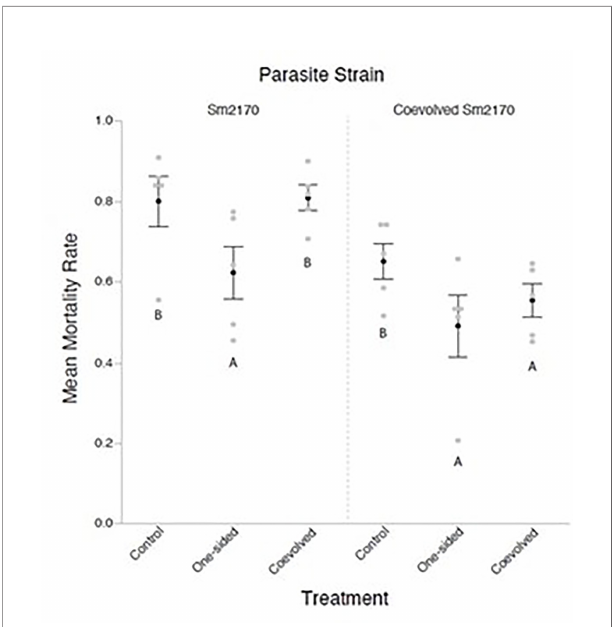
FIGURE 2 | Host Mortality across related parasites. For each mortality assay 200 Worms were exposed to S. marcescens for a period of 48 hours using Serratia Selection Plates. Surviving worms were counted and the mortality is expressed as (worms plated – worms counted)/worms plated). Black circles represent the average mortality rate across all host populations for each bacterial treatment group. White circles represent the average mortality rate across all replicates for one host population. Points which share letters are statistically indistinguishable from each other, and only apply within their respective column. Error bars represent standard error. Letters are differentiated by a =